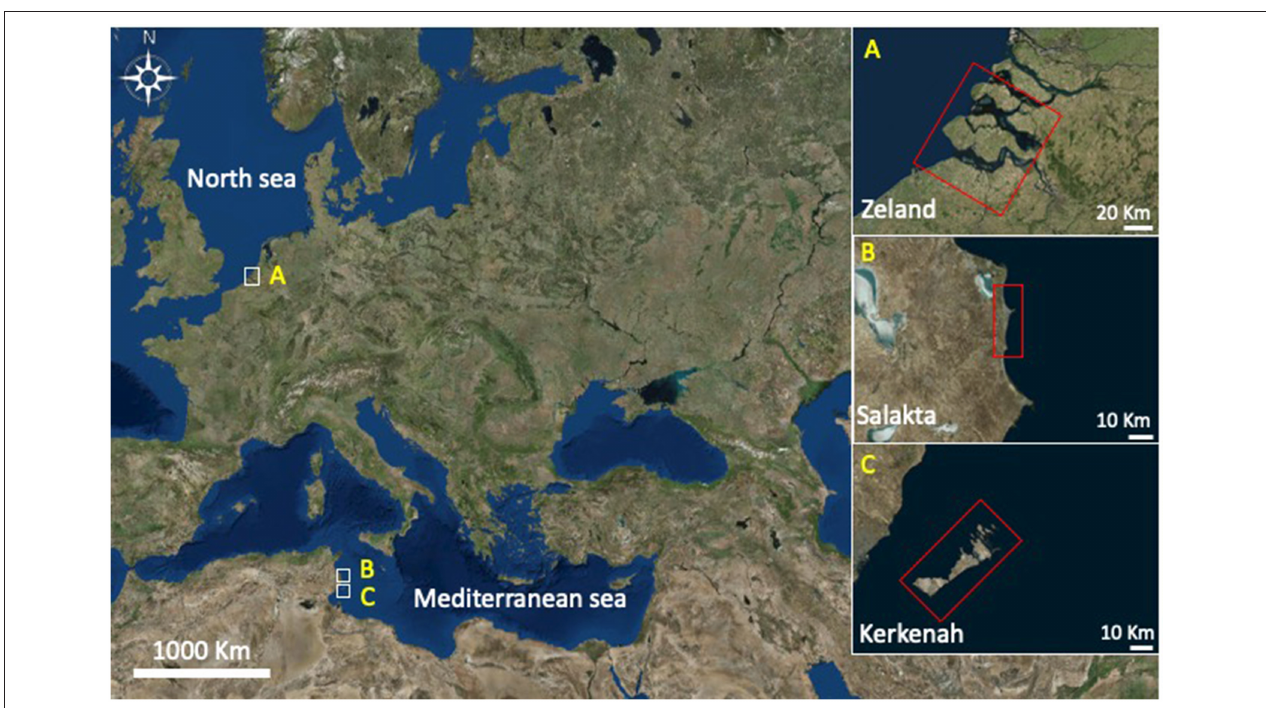
TABLE 1 | Seawater samples composition by Green lab-TUNAC-Tunisia (All parameters are expressed in mg L − 1 ). Seawater